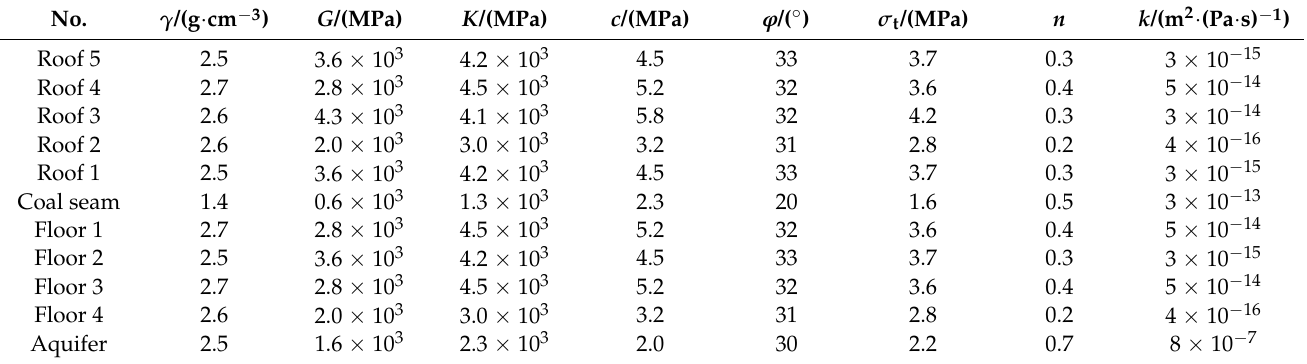
Table 1. Physico-mechanical parameters of rocks and the coal seam.